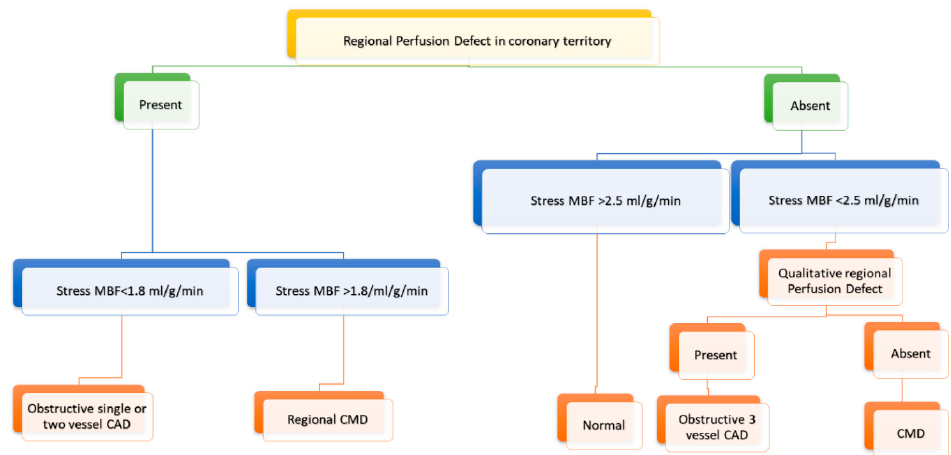
Figure 5. Diagnostic algorithm at Rush University Medical Center for detection of obstructive CAD (coronary artery disease) and coronary microvascular dysfunction (CMD) using regadenoson stress CMR (cardiovascular magnetic resonance) perfusion. MBF, Myocardial blood flow.